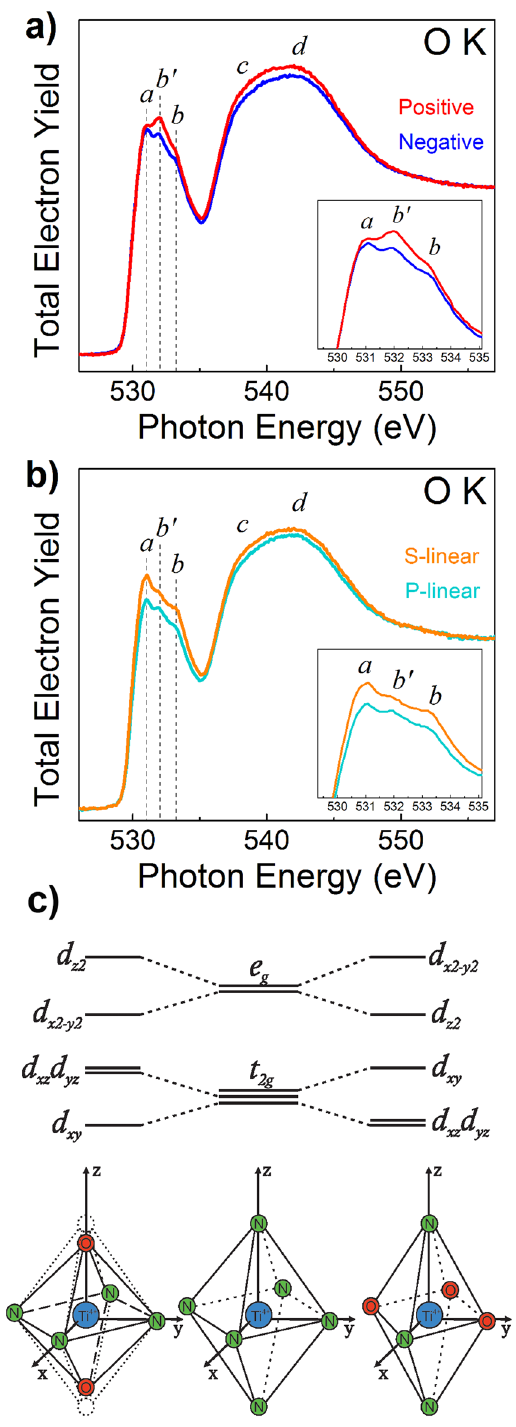
Figure 8. O K-absorption spectra for TiN/Al 2 O 3 /Si stack measured at the grazing incidence angle of 90° using the elliptical ( a ) and linear ( b ) light polarization. All the spectra were normalized to the continuum jump after subtraction of linear background extrapolated from the energy region below the O1s absorption onset. Panel (c) shows schematics of d-state splitting in a perturbed crystal field (compressed and stretched